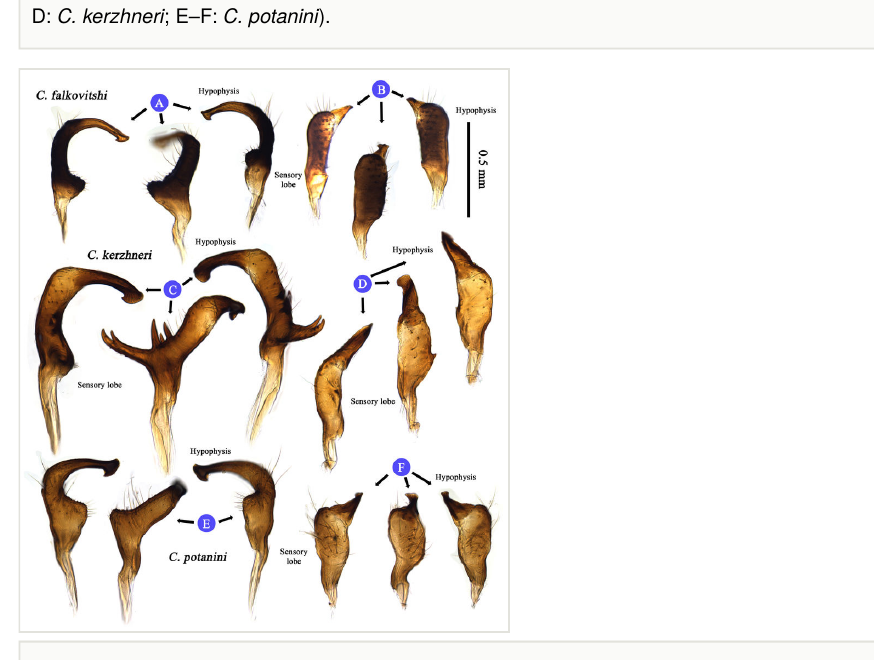
Figure 3. Male genital structure (Parameres) of Korean Castanopsides species (A–B: C. falkovitshi ; C– D: C. kerzhneri ; E–F: C. potanini ) – A, C, E: Left paramere. B, D, F: Right